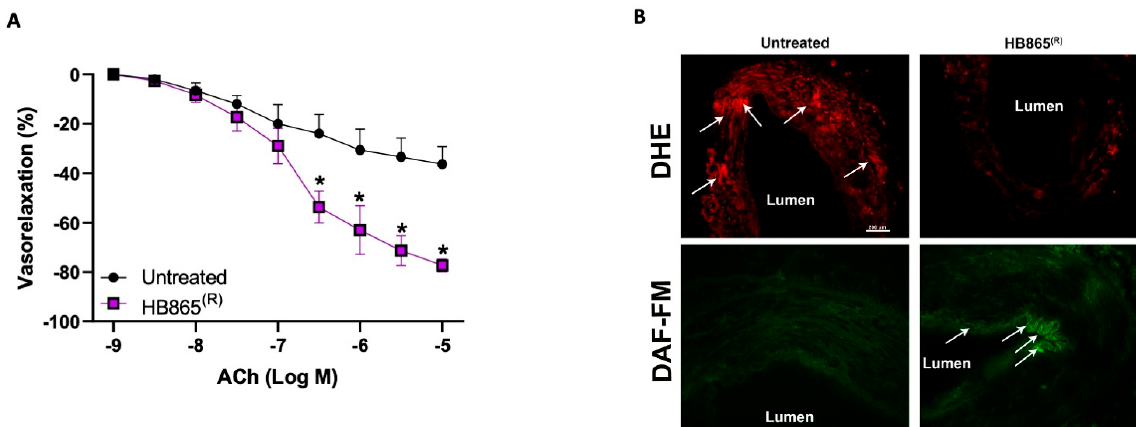
Figure 8. ( A ) Dose–response curves of relaxation of human superior thyroid artery (STA) collected from hypertensive and dyslipidemic patients in response to increasing doses of acetylcholine (ACh) alone, or after preincubation with HB865 ® for 1 h at the dosage of 50 µM. The response obtained was expressed as the percentage. Data are given as mean ± SEM ( N =